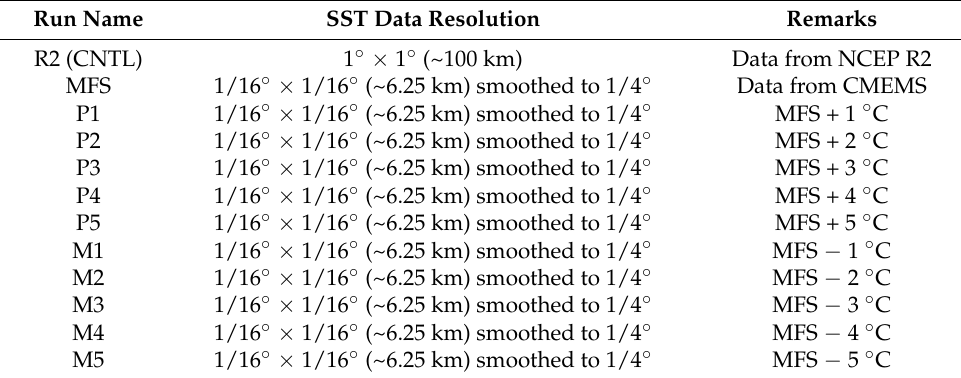
Table 1. Summary of all model runs and specified SST. SST values are daily means and are updated once every 24 h during each